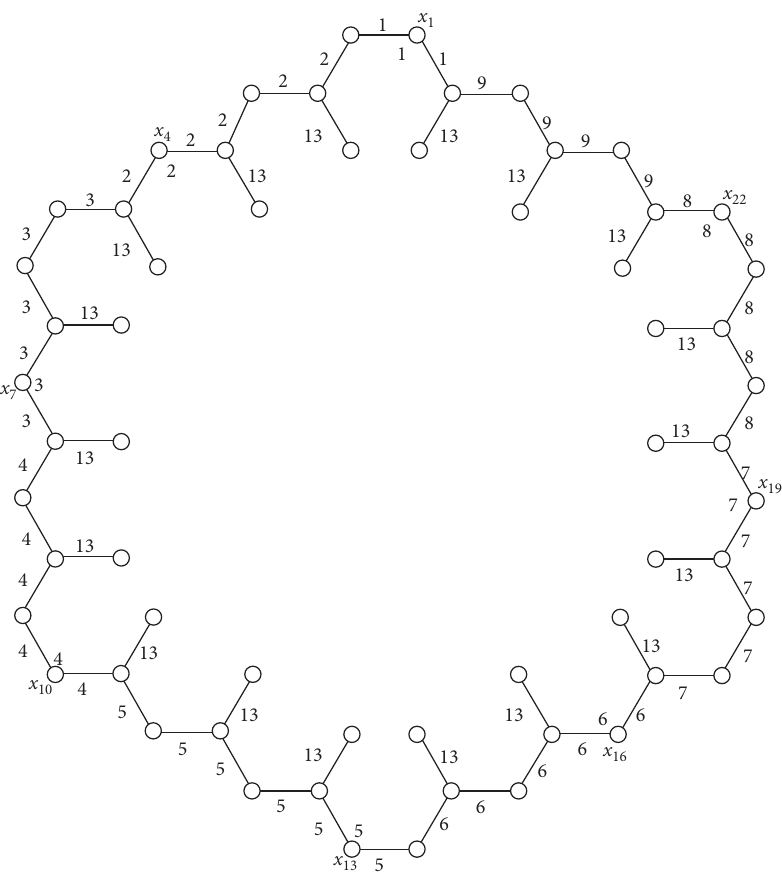
Figure 8: The labels of some vertices and edges of L